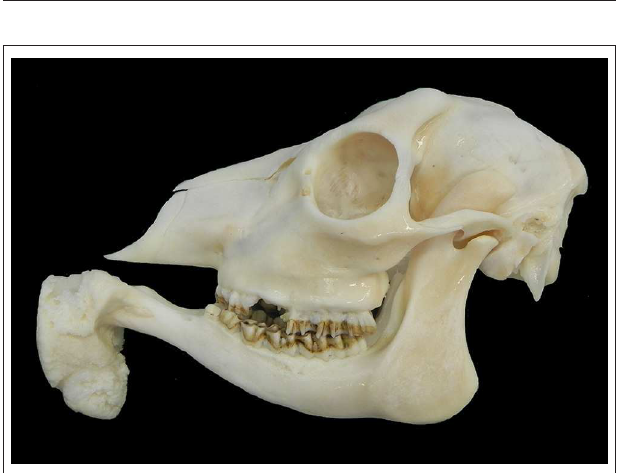
FIGURE 2 | Skull, roe deer; the mass is composed of a bony